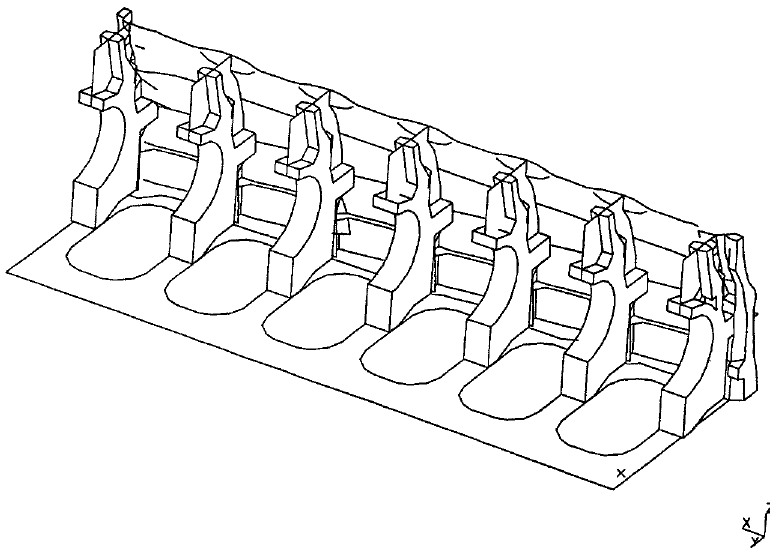
Fig. 8. Ladder frame